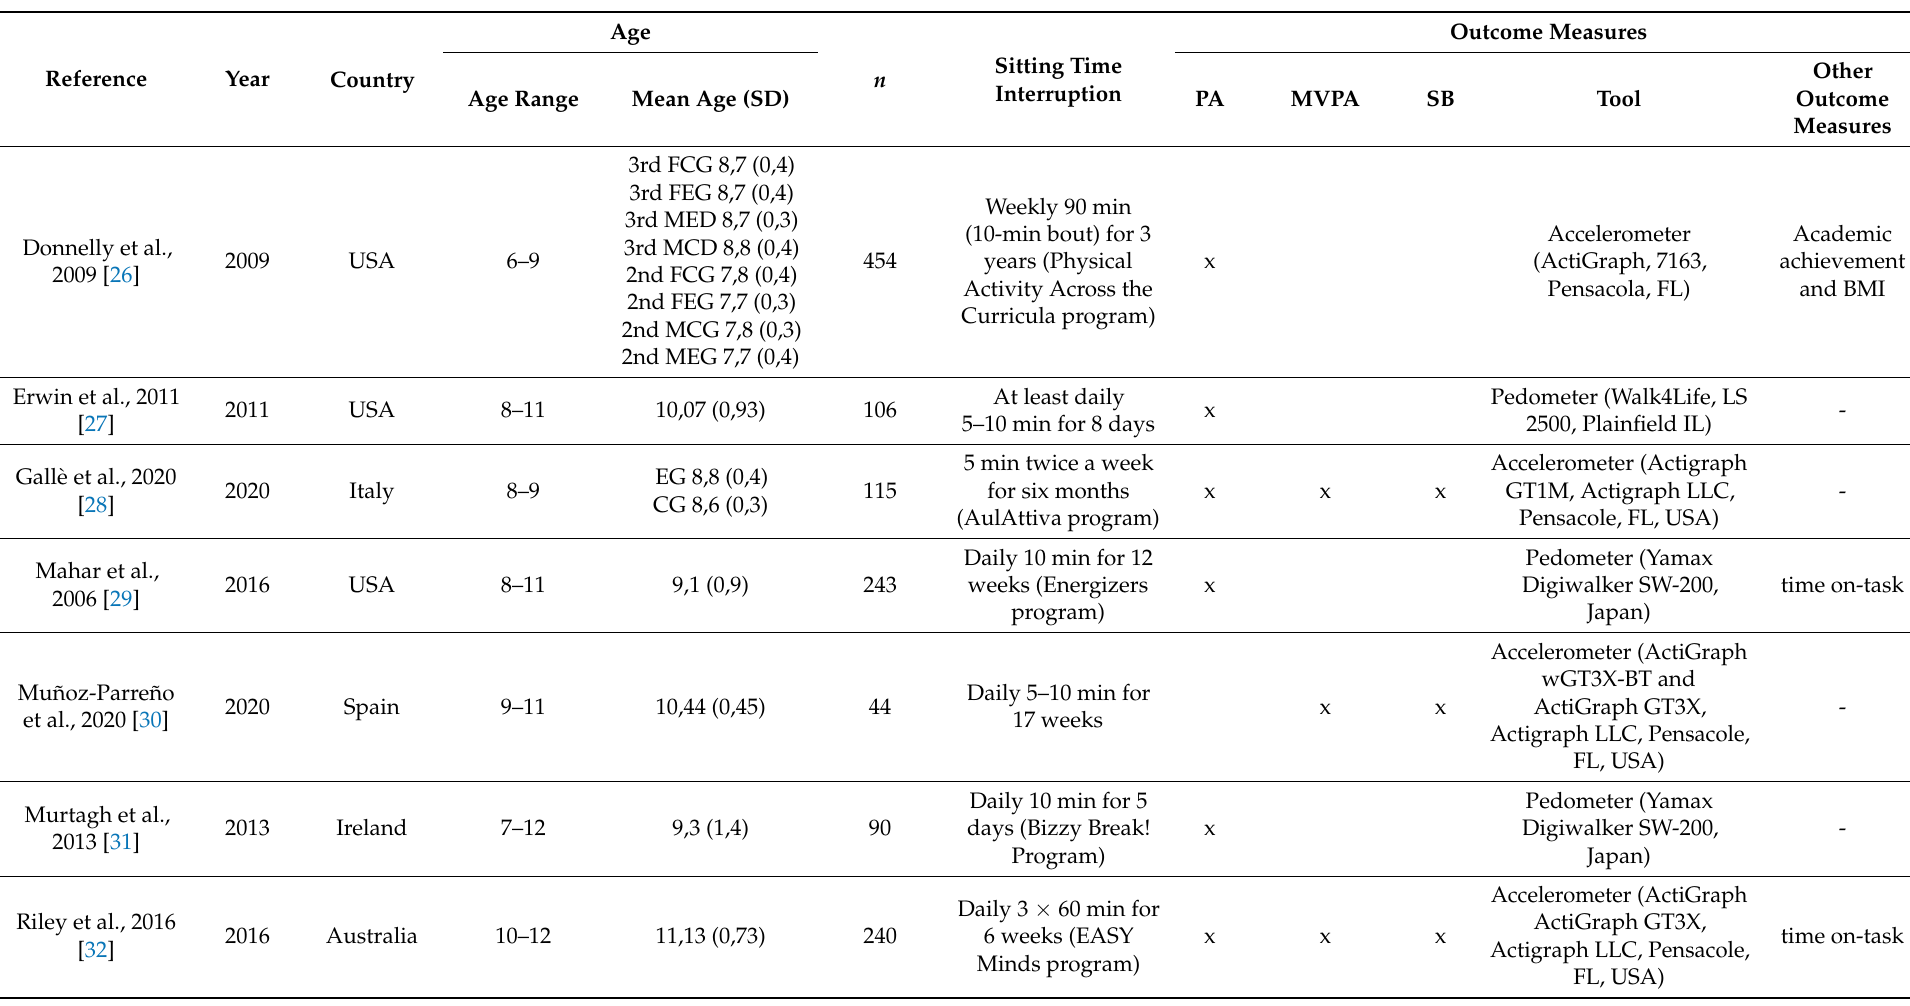
Table 1. Characteristics of the included